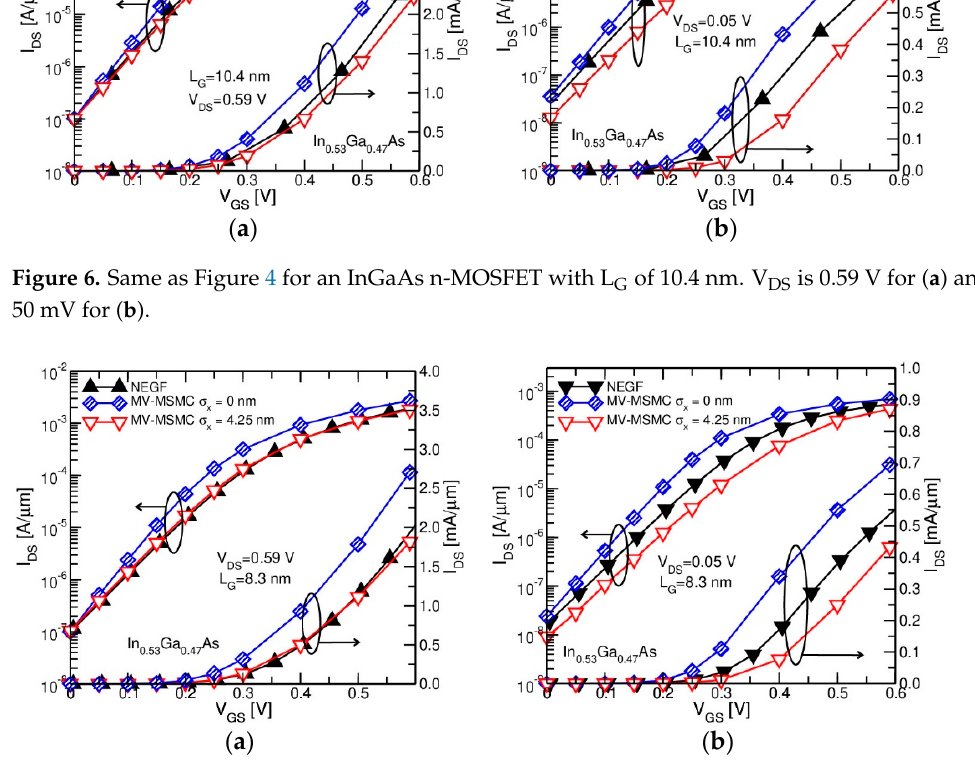
Figure 7. Same as Figure 4 for an InGaAs n-MOSFET with L G of 8.3 nm. V DS is 0.59 V for ( a ) and 50 mV for ( b ).